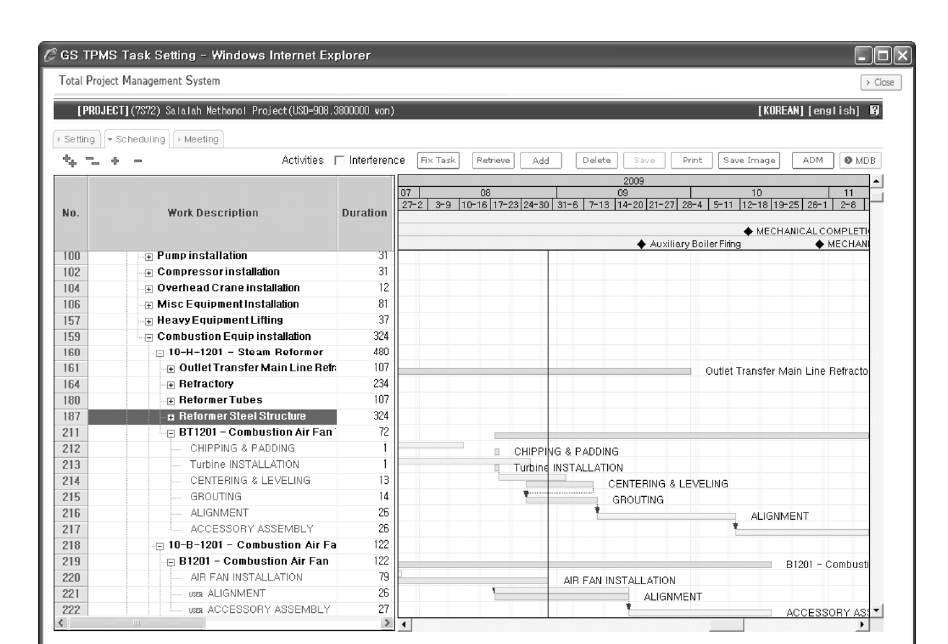
Fig. 11. Example of task